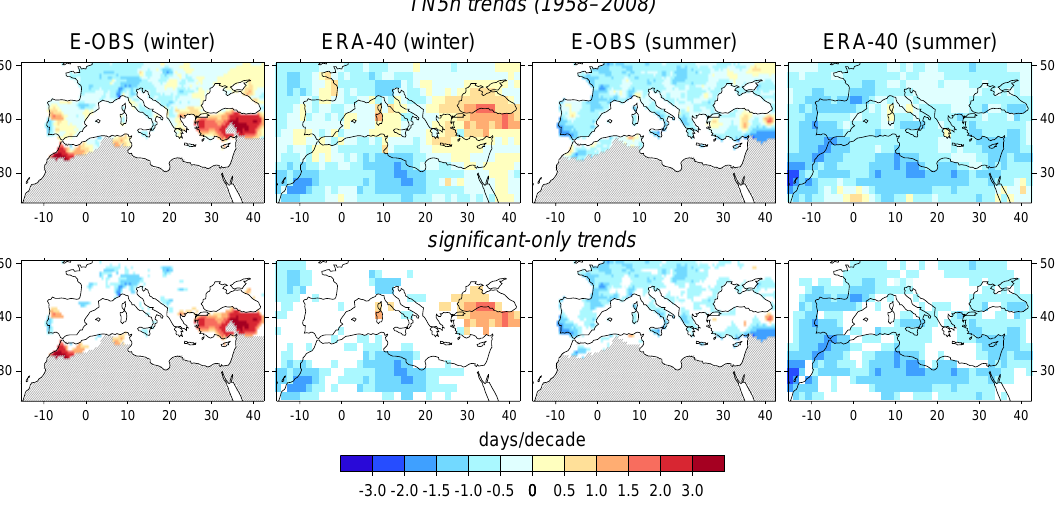
Fig. 3. Trends of winter (left-hand columns) and summer (right-hand columns) TN5n (days per decade), over the period 1958–2008, from E-OBS and ERA-40 data. The lower panel shows only statistically-significant trends. Gray-shaded areas in E-OBS trend maps correspond to grid-points with missing years in the 1961–1990 base-line period (or with no data at all).